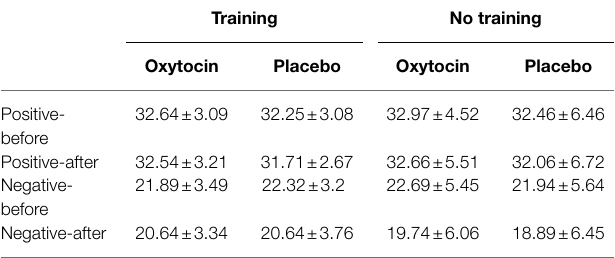
TABLE 5 | The positive and negative affect of participants in Study 3 ( M ± SD ).